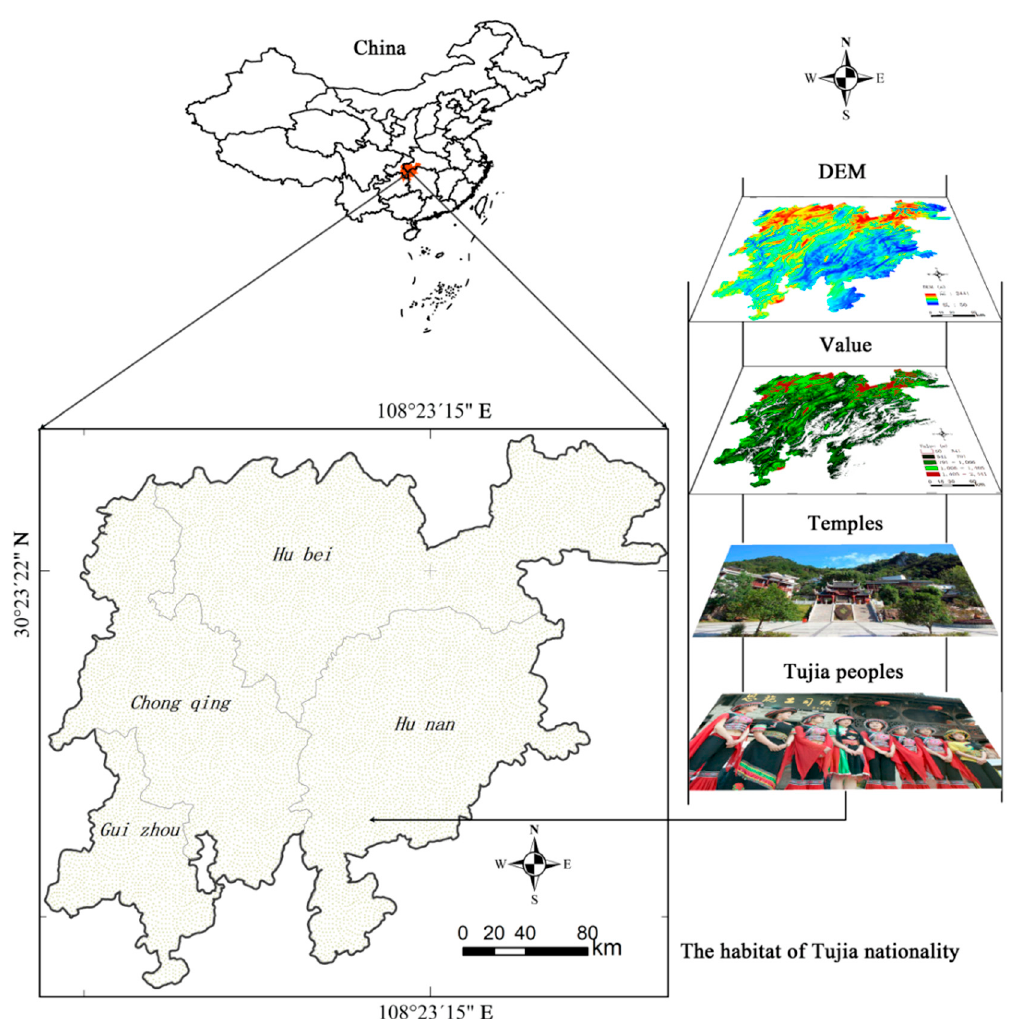
Figure 1. Tujia settlement area.